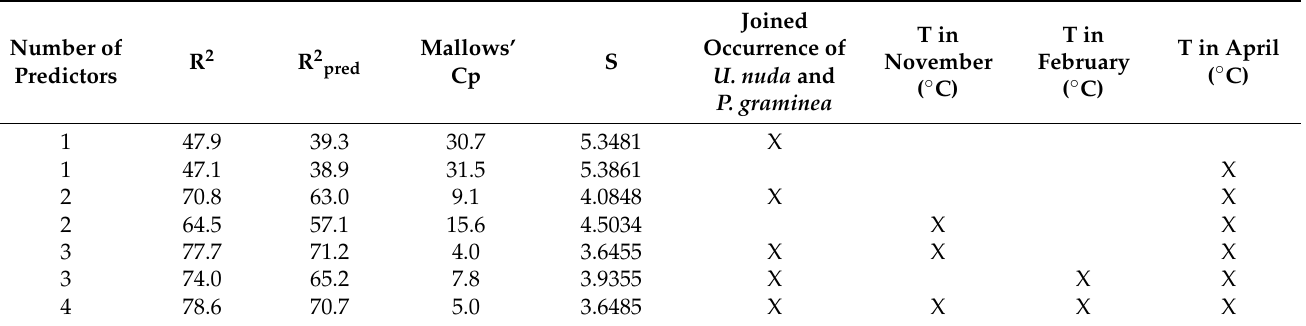
Table 4. Best subsets regression analysis of the most influencing factors on yield loss of